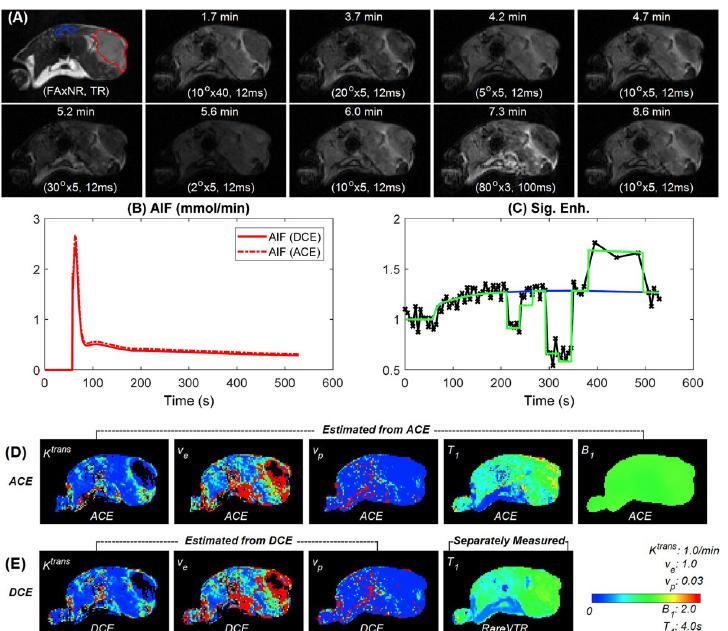
Fig 1. A representative example (4T1 flank tumor) of pharmacokinetic model parameter estimation using ACE-MRI and DCE-MRI protocol. (a) Demonstration axial images at different ACE-MRI encoding stages with reference muscle ROI (blue) and tumor ROI (red) overlay on T 2 weighted image. (b) AIF functions from reference tissue method for ACE-MRI (dashed line) and DCE-MRI (solid line). (c) Demonstration tumor voxel enhancement curve (black cross) with ACE-MRI fitting (green solid) and DCE-MRI fitting (blue solid). (d) K trans , v e , v p , T 1 and B 1 parameter maps simultaneously estimated with ACE-MRI protocol. (e) K trans , v with DCE-MRI protocol with separately measured T 1 map using the RARE-VTR